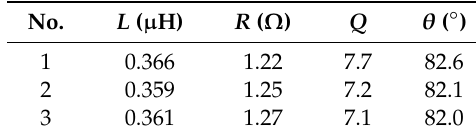
Table 1. Parameters of three sample coils.